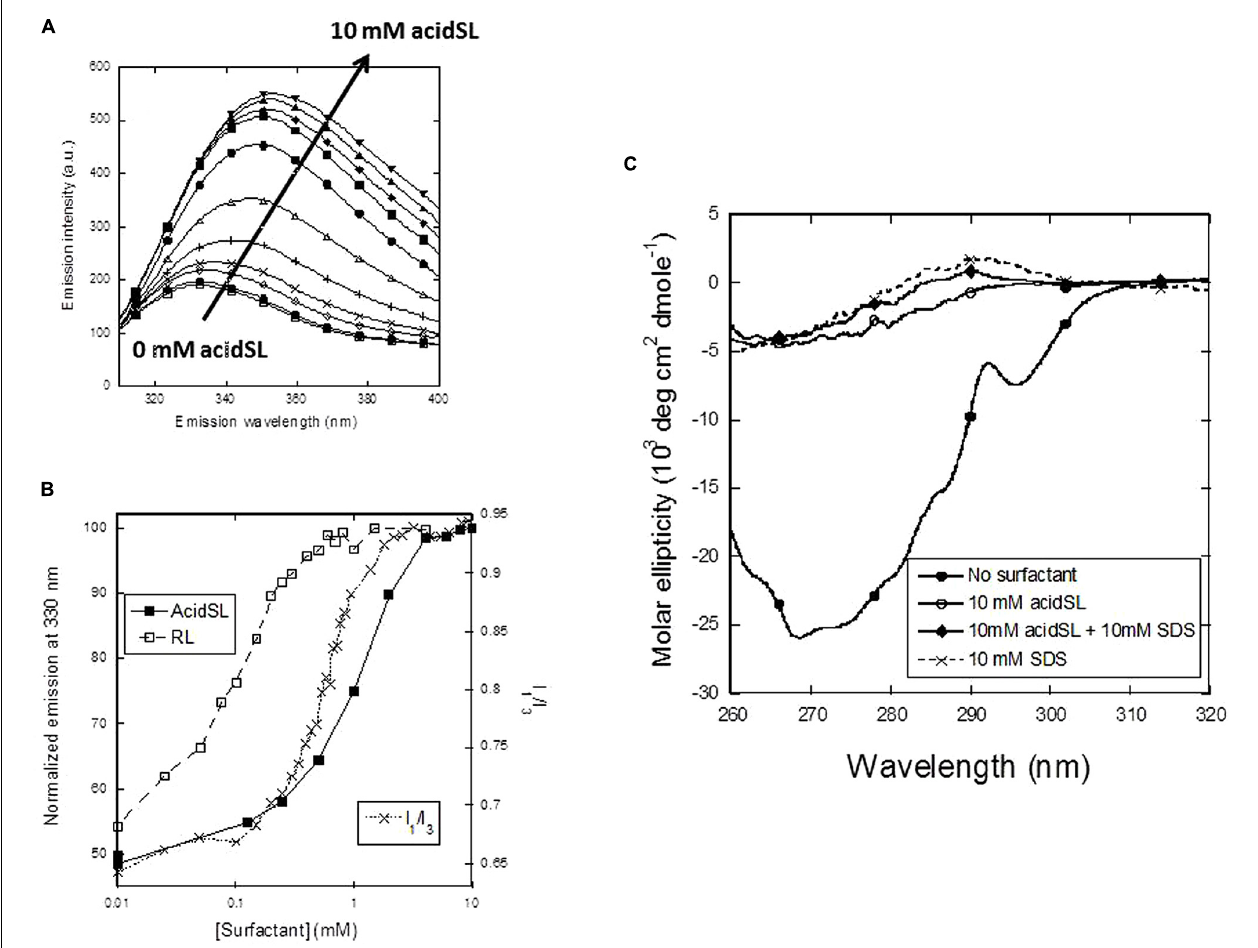
FIGURE 3 | Unfolding of apo-aLA in acidSL. (A) Trp fluorescence emission spectra undergo a red shift at higher acidSL concentrations. (B) Trp fluorescence plots of apo-aLA in acidSl and RL (left axis) compared with the pyrene plot of apo-aLA in SL (right axis). (C) Near-UV CD spectra of apo-aLA in different